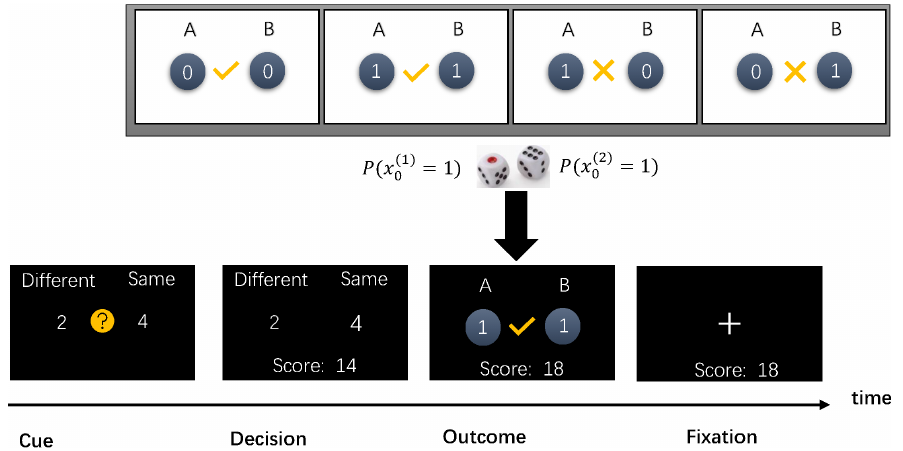
Figure 2. A gambling task. Cautious gamblers participated in a simple decision-making task in a volatile environment. There were four phases in a trial. (1) Cue : Two options and their rewards were presented; (2) Decision . Once the gambler had made a choice, the choice was displayed bigger and was highlighted; (3) Outcome . Once the two arms (denoted by letters A,B) had randomly generated their states, the outcome of the choice was output and then made an increment of the score only if the choice was right. (4) Fixation . This phase was the interval between trials. The screen only presented the score until the beginning of the next